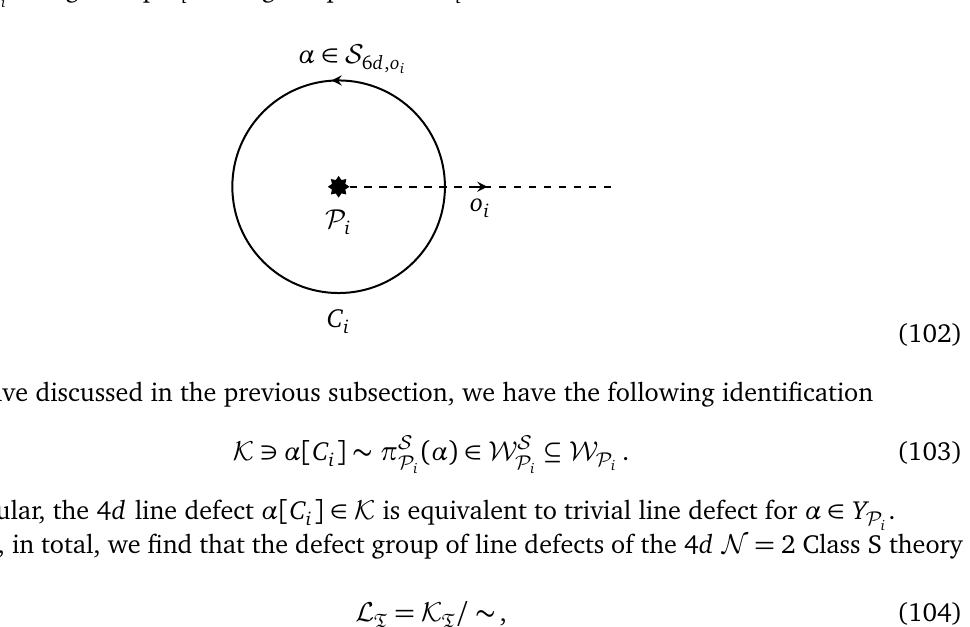
along the loop C encircling punctures P and P is equiv- i j 6 d · β along the path C going i i , j to the puncture P . Here the dashed line denotes the outer- i j